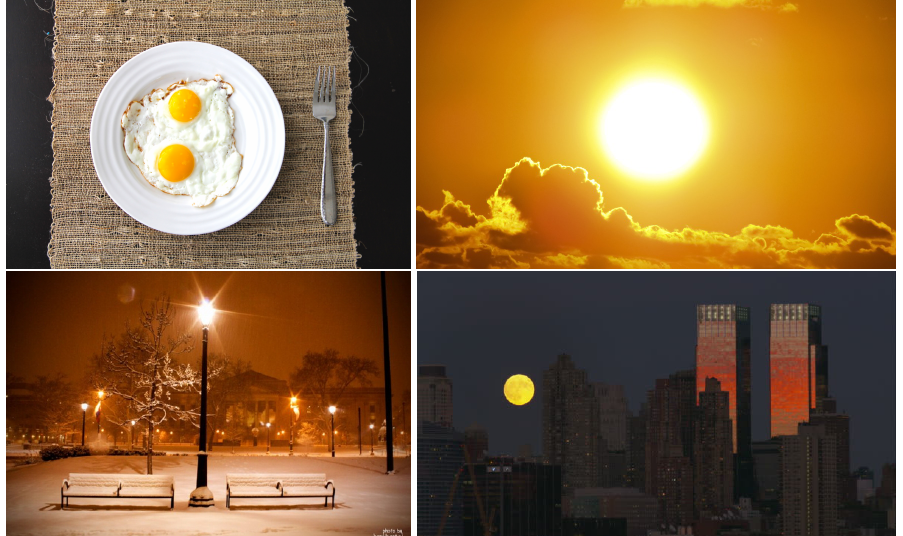
Figure 1. Examples of similar objects; the shapes, colors, and textures are similar. It could be difficult for typical feature extractors to clearly capture the characteristics of objects with with local context. In these cases, global context from the entire image could help the detectors to identify objects more